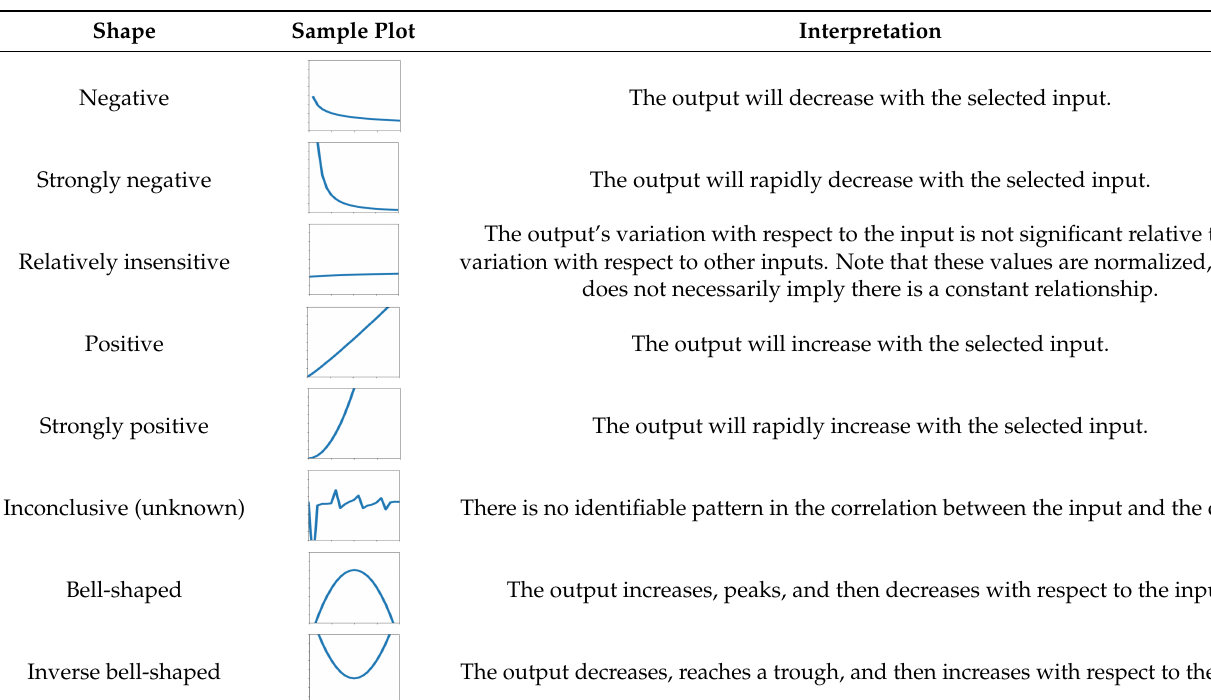
Table 4. Input-output relationship types and interpretations.